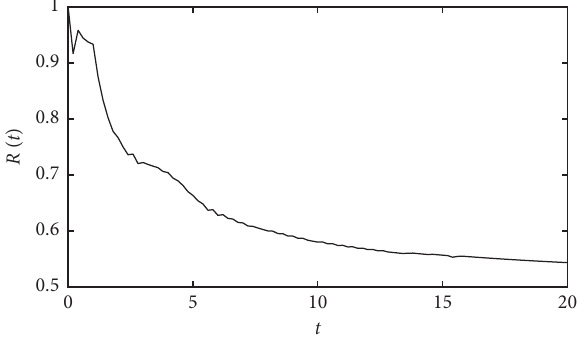
Figure 3: The trajectory of R ( t ) for t ≤ 20.